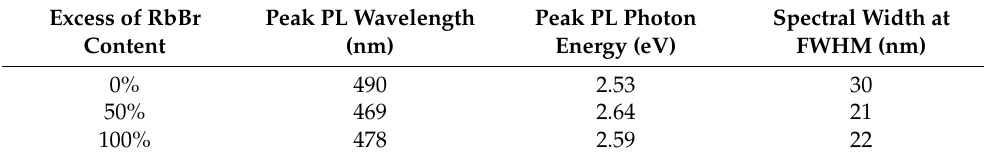
Table 1. Wavelength and photon energies of peak positions and full width at half-maximum (FWHM) of PL bands in samples with different amounts of excess RbBr content.